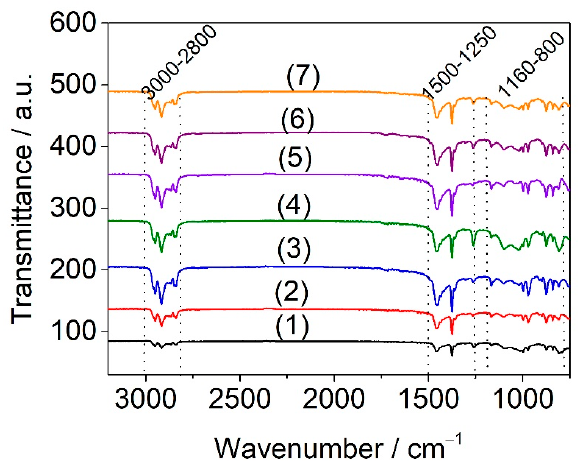
Figure 6. ATR-FT-IR spectra of PPW (1), PPW/SBSBC (2), PPW/SBSBC/n-Clay 5% (3), PPW/SBSBC/n-Clay 10% (4), PWP/SISBC (5), PPW/SISBC/n-Clay 5% (6), and PPW/SISBC/n-Clay 10% (7) samples.